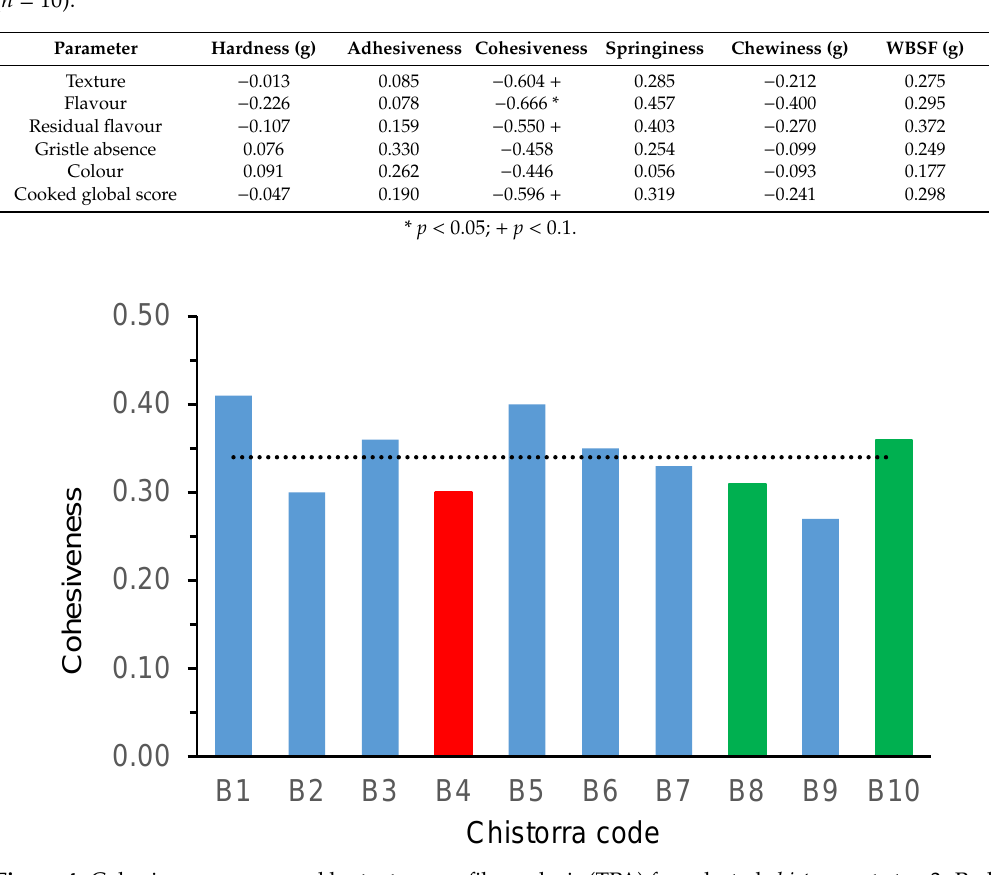
Figure 4. Cohesiveness measured by texture profile analysis (TPA) for selected chistorras at step 3. Red bar, refers to the winner chistorra ; green bars, refer to the finalist ones; mean value is represented by a dotted line.